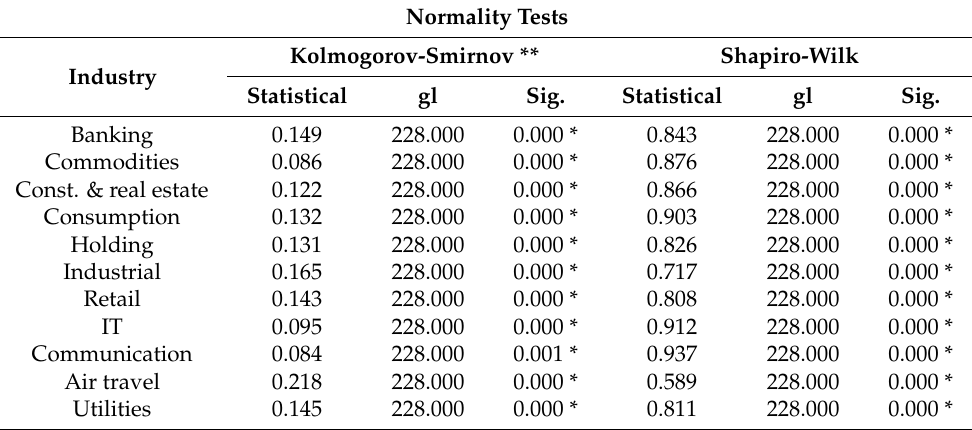
Table 4. Statistical significance per industry of normality